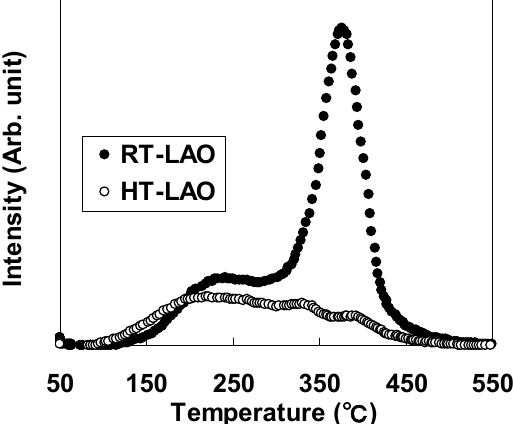
O) for RT-LAO and 2